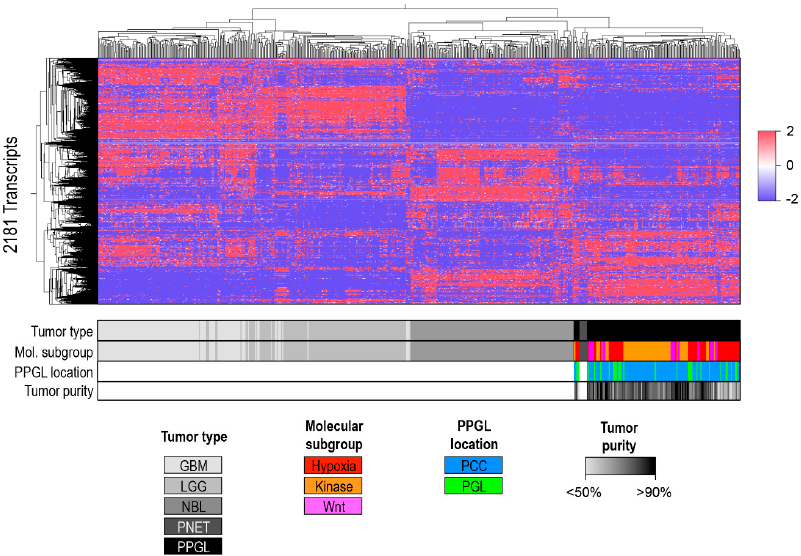
Figure 4. Pan-glioma-neuroendocrine tumors cluster. Unsupervised clustering of RNA-seq data of GBM ( n = 150), LGG ( n = 150), NBL ( n = 156), PNET ( n = 8) and PPGL (cortical admixture excluded, n = 152) processed by bioinformatics pipeline 1.